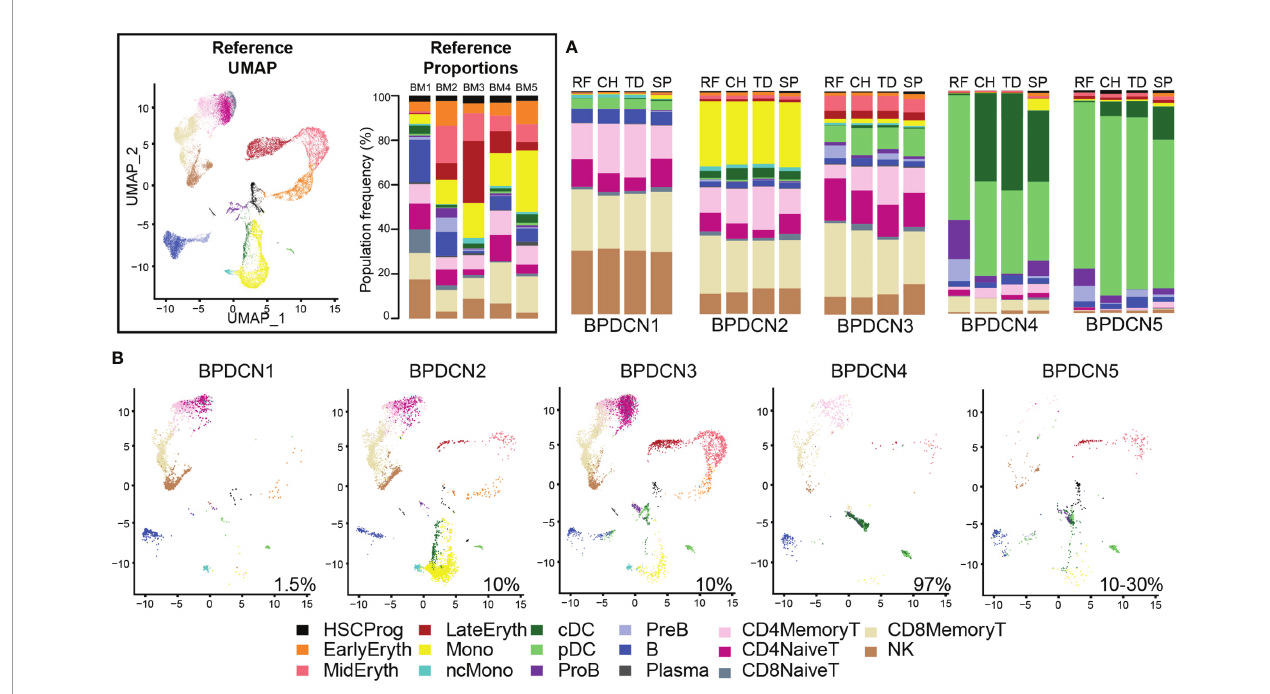
FIGURE 2 | Classi fi cation of BPDCN samples using healthy references. (A) Stacked barplots show the frequencies of cell types in fi ve BPDCN samples as classi fi ed by four algorithms: RF, random forest; CH, cellHarmony; TD, Seurat TransferData; and SP, scPred. (B) UMAP visualization of cells from fi ve BPDCN samples in the same UMAP space as the integrated reference. Colors in the cell-type proportions and UMAP visualizations are coded by the legend. For comparison with healthy controls, reference UMAP and proportions for each healthy sample are provided in the black